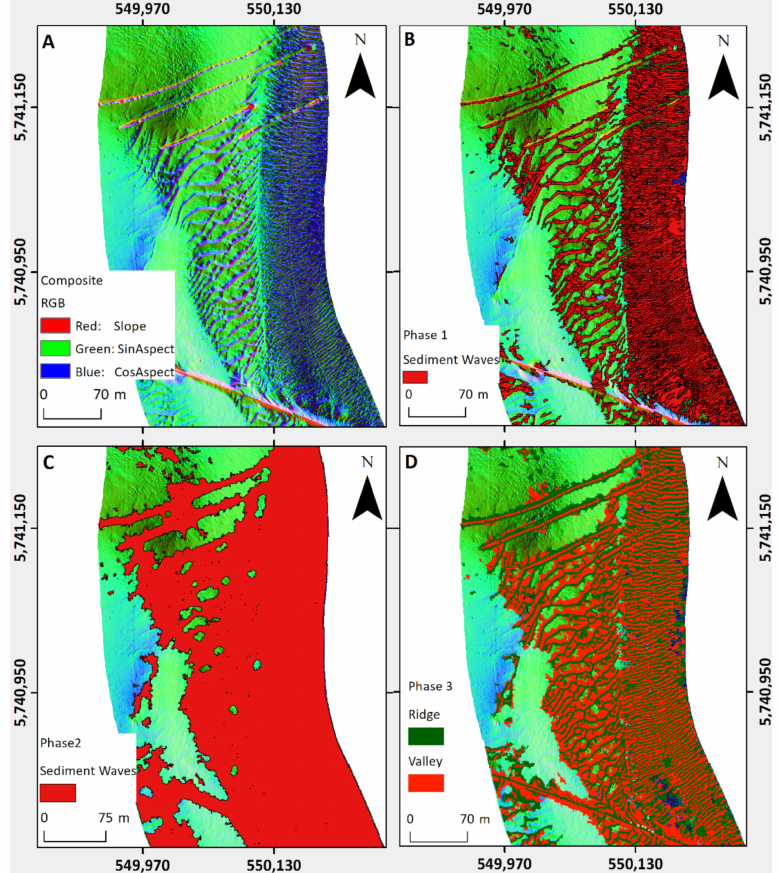
Figure 3. An example of ( A ) a red, green, and blue (RGB) 3-band composite image of slope (R), sinaspect (G), and cosaspect ( B ) derived from the bathymetry at Cork Harbour; ( B ) the product of the first phase of segmentation; ( C ) the product of the second phase of segmentation; and ( D ) the product of the third phase of